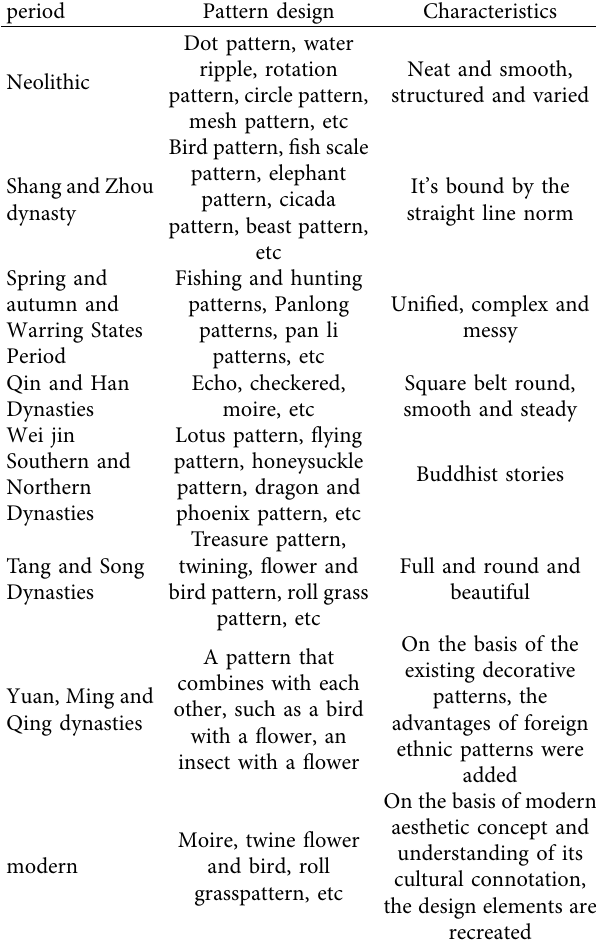
Table 3: Development process of Hakka traditional decorative pattern